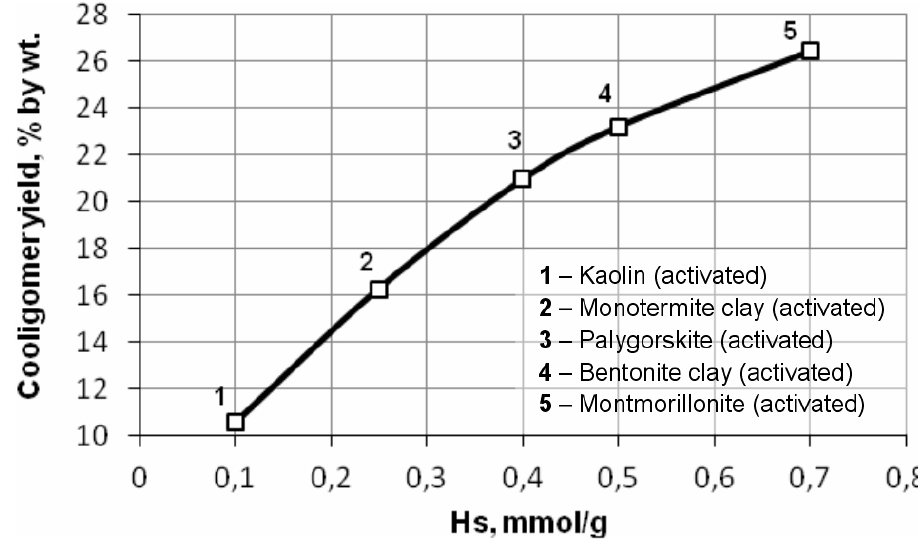
Figure 4. The relationship between the catalyst active sites concentration and cooligomer yield. Table 2. The properties of the cooligomers obtained when using silica-alumina catalysts.